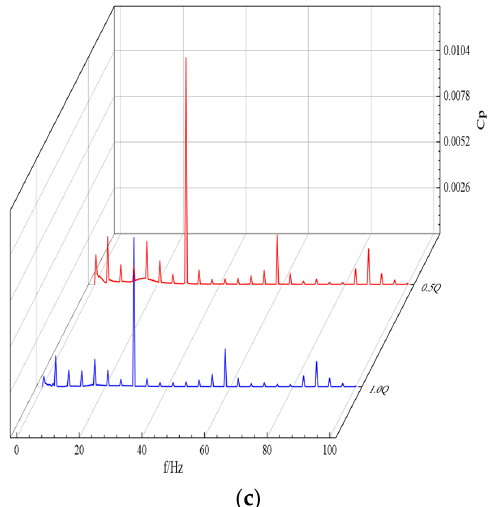
Figure 11. The frequency domain distribution of pressure pulsation under turbine operating condi- tions. ( a ) Monitoring point a3 ( b ) Monitoring point b3. ( c ) Monitoring point c3.